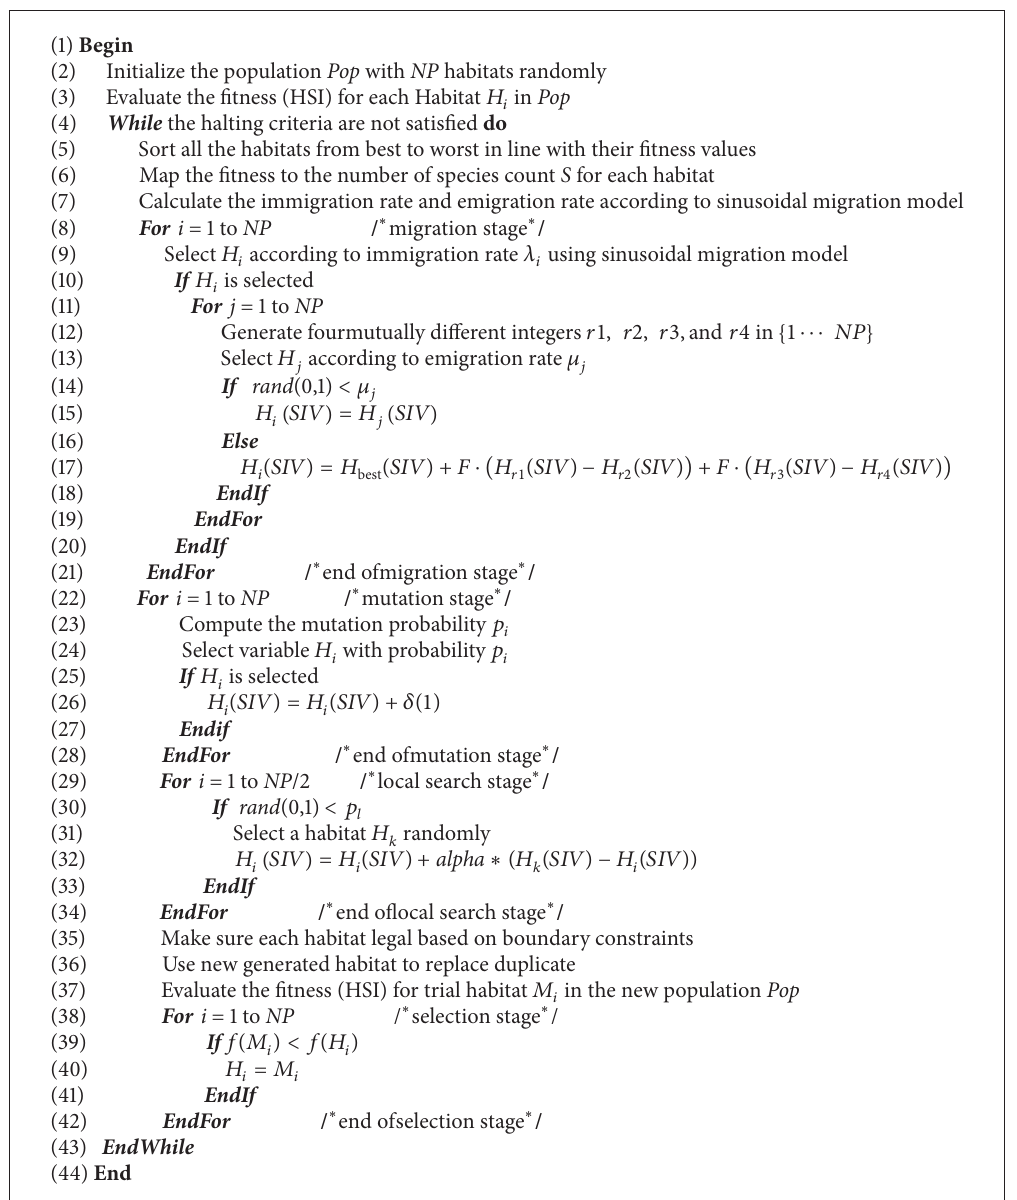
Algorithm 4: Pseudocode of